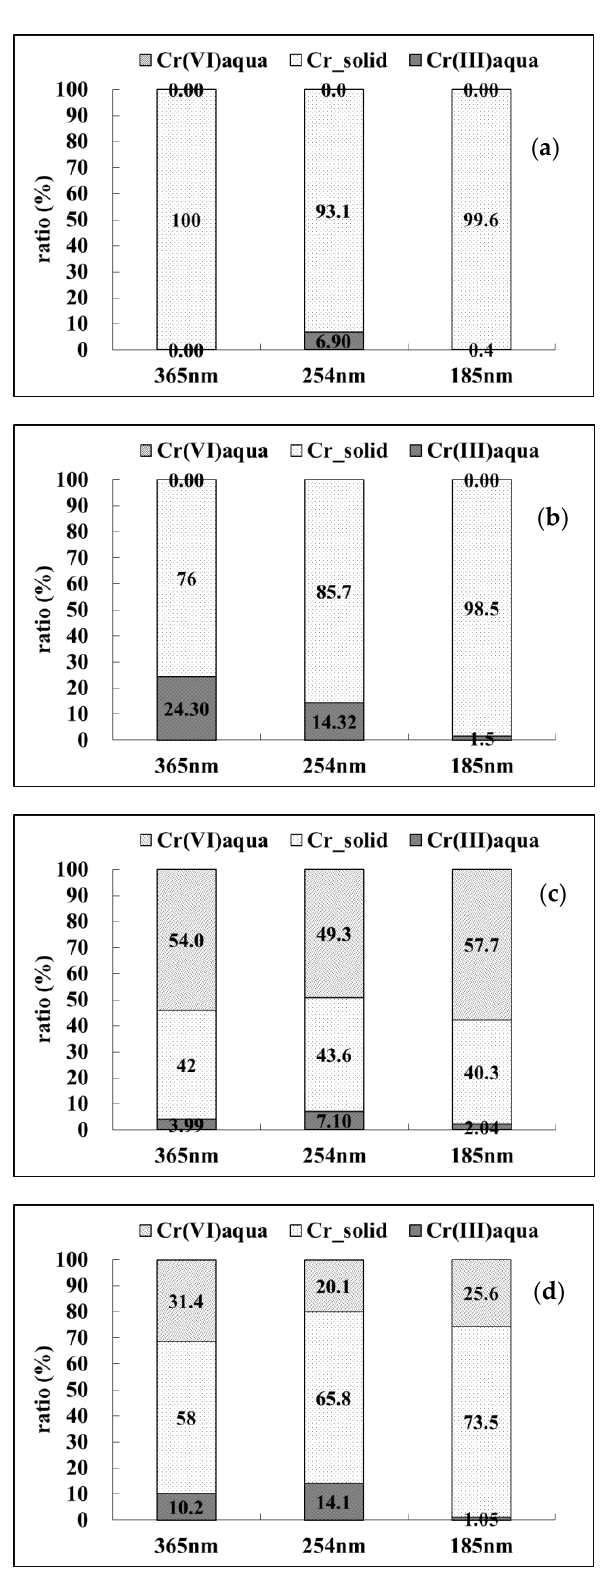
Figure 3. Effects of the wavelength factor on chromium species distribution after photo-reduction by TiO 2 ( a ) Cr 3 mgL − 1 alone, ( b ) 3 mgL − 1 of Cr(VI) coupled with 10 mgL − 1 of SA, ( c ) Cr 20 mgL − 1 alone, and ( d ) 20 mgL − 1 of Cr(VI) coupled with 10 mgL − 1 of